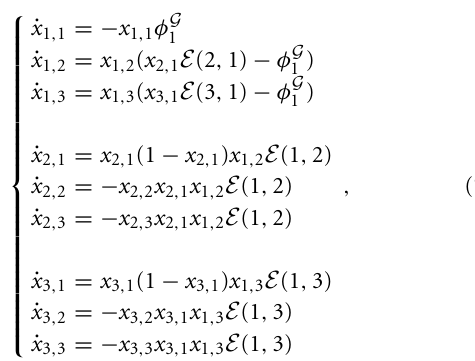
formation of a single connection and (D) represents the onset of multiple connections. The state variables x v , w describing the dynamics of the system according to Equation (7) are also reported as labels of arcs of the